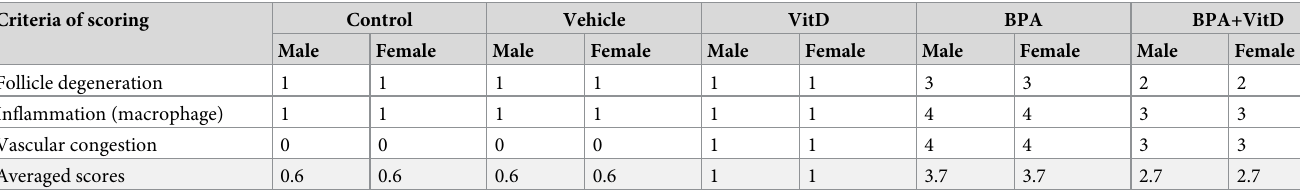
Table 1. Comparison of injury scores between different treatment groups. Criteria of